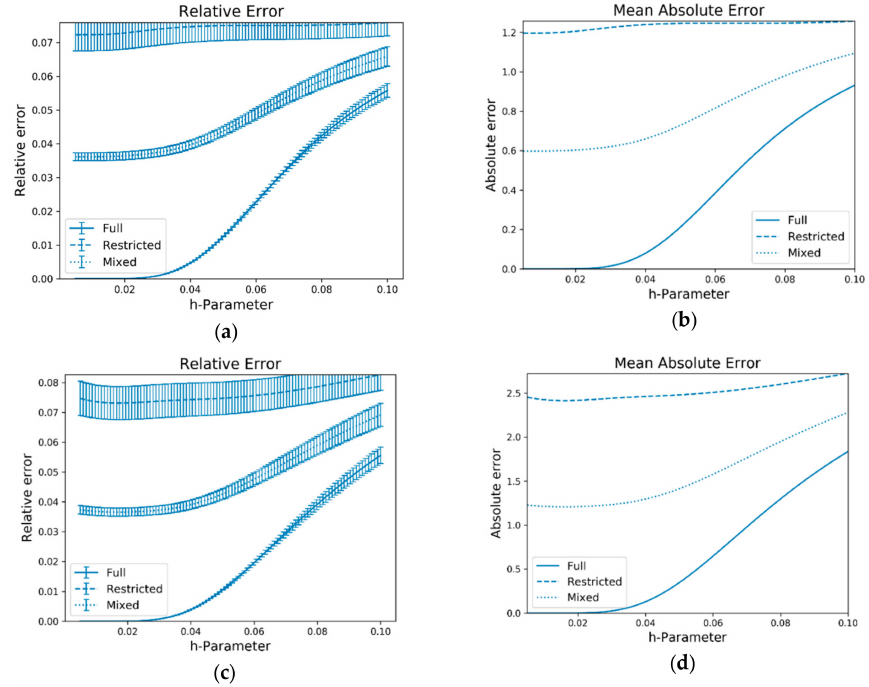
Figure 17. Results of the cooling load problem for the complete and reduced variable dataset models with the parameter selection h = ω . ( a ) MAPE depending on h for the model one-floor model with four variables; ( b ) MAE depending on h for the one-floor model; ( c ) MAPE depending on h for the two-floors model with five variables; ( d ) MAE depending on h for the two-floors